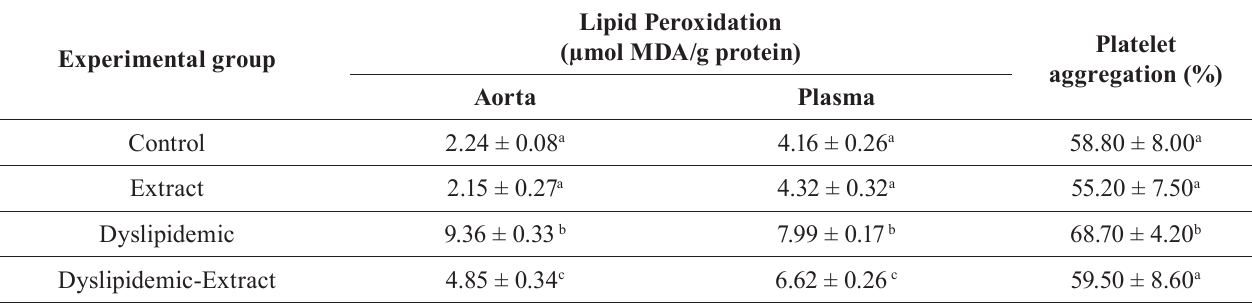
The values represent the average ± standard deviation of eight experiments per treatment. Averages followed by the same letter in the same column do not differ statistically. Different letters (a, b, c) in same column indicate statistical significance by Scott-Knott Test, p < 0.05. MDA: